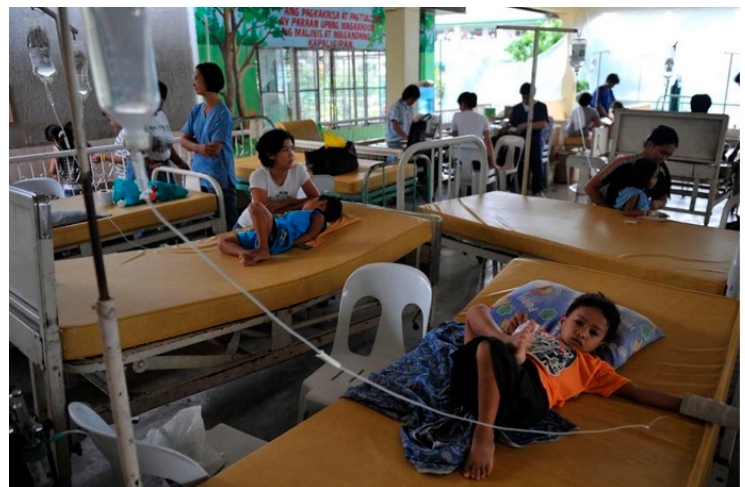
Figure A4. Stimulus Image for the Human Health Message.